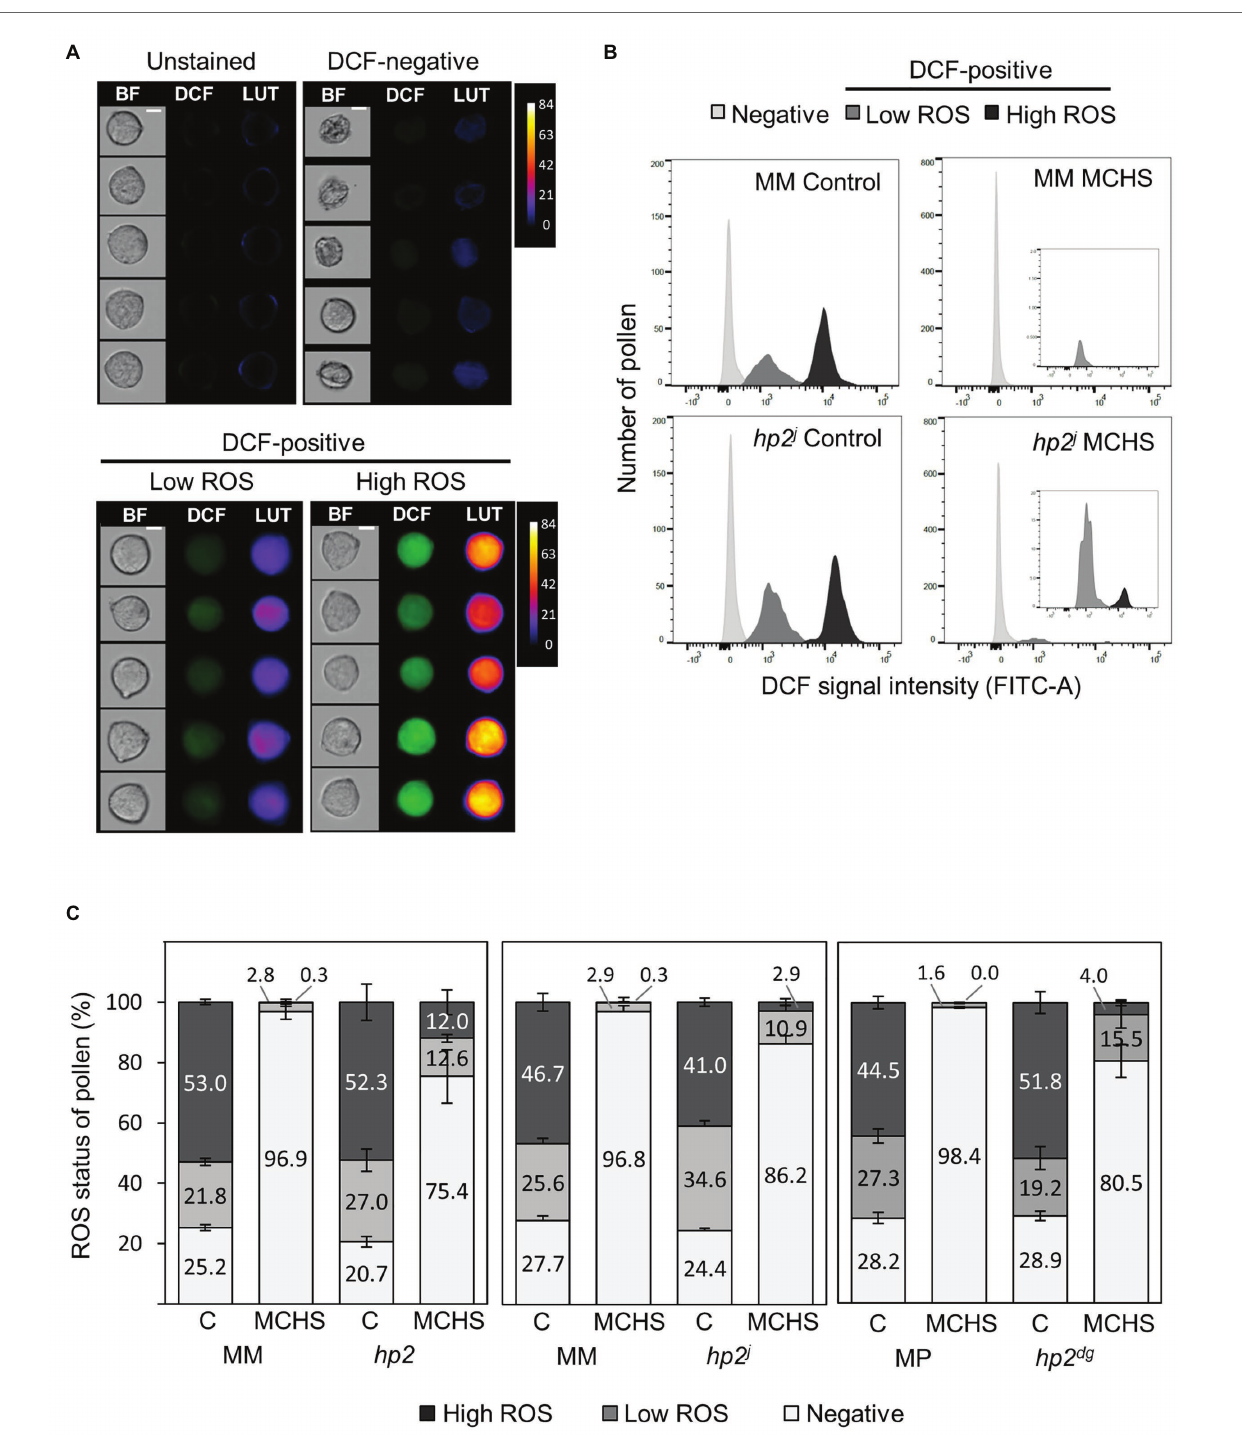
FIGURE 2 | The hp2 mutant maintains higher pollen viability and metabolic activity under moderate chronic heat stress (MCHS) conditions. (A) Dichlorofluorescein (DCF) fluorescence of randomly selected pollen grains from unstained and 2 ' ,7 ' -dichlorodihydrofluorescein diacetate (H 2 DCFDA)-stained samples of Moneymaker wild type line under control conditions. Pseudo-color lookup table (LUT) images emphasize the scale of DCF fluorescent intensity. BF, bright field images. Scale bar = 10 μ m. (B) Distribution of pollen by DCF-signal intensity. Inset boxes zoom into the DCF-positive fraction, which is smaller under MCHS conditions in all genotypes. (C) Distributions of reactive oxygen species (ROS) status (negative, low, or high) of pollen across genotypes and conditions. Numbers denote the percentage of each status fraction. Differences between hp and wild type lines in viable pollen (low, high, or both) under MCHS conditions were statistically significant (3–6 replicates, value of p < 0.04). Error bars represent SEM. MCHS, moderate chronic heat stress; C, control conditions; MM, moneymaker; and MP,